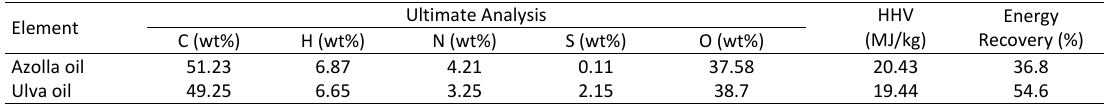
Table 5: Ultimate analysis, high heating values and energy recovery values for the bio-oils obtained from the pyrolysis of A. filiculoide and U. fasciata